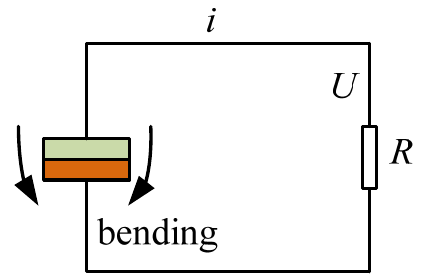
Figure 6. Equivalent circuit of piezoelectric MFC.